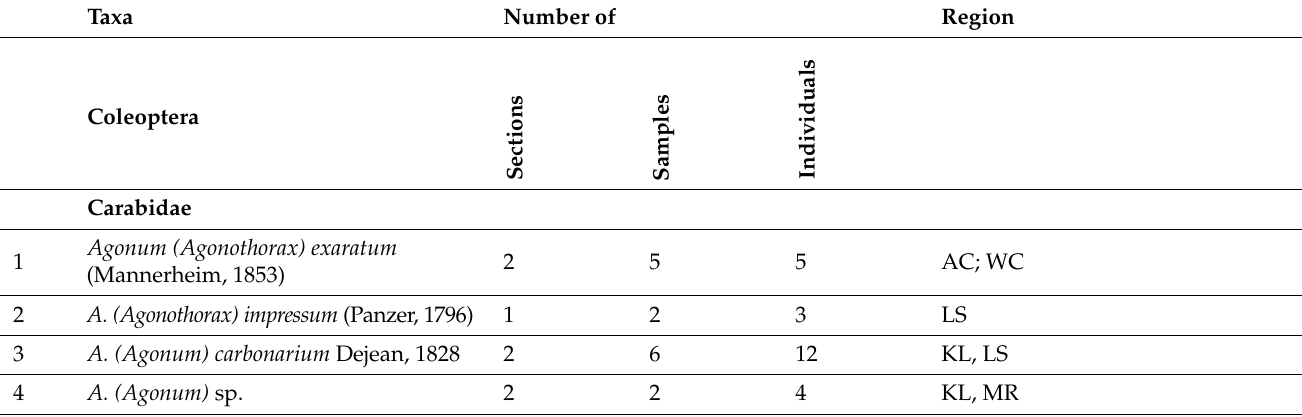
Figure 11. Remains of true aquatic insects: ( a )—Odonata larvae wing pad., ( b – d )—plant-silt cases of Trichoptera, Brachycentridae: ( b )— Brachycentrus subnubilus , ( c )— Micrasema sp., ( d )— Micrasema gelidum , ( e ) sand case of Apataniidae, ( f ) sand case of Molanna sp., ( g , h )— Limnephilus spp.: ( g ) plant case, ( h ) sand case, ( i ) shell case, ( j ) case from shells, seeds and a beetle elytron; ( a , b , h )—Kharyyalakh, Holocene, ( c ) Old Crow, late Pleistocene (MIS5), ( d , e , f ) Ulakhan-Sullar, middle Pleistocene, ( g ) Kyzyl-Syr, late Pleistocene (MIS3) peat, ( i , j ) Peschanay Gora, late Pleistocene (MIS2). Table 1. List of aquatic beetles from Quaternary deposit of Beringia. The group “ri” (Table 2) includes beetles of families Carabidae, Hydrophilidae, Staphylin- idae, Scarabaeidae, Scirtidae, Heteroceridae, Elateridae, Coccinellidae, Chrysomelidae, Curculionidae, and bugs Saldidae. These insects live on wet ground, in plant litter near water bodies (Figure 12), or on riparian and wetland vegetation (Figure 13). Many riparian species can migrate to dry soils for wintering. In the cold climate, some riparian species occasionally visit dry and sunny spots to get some heat necessary for their development. Anyway, the find of “ri” group suggests that a water body existed not far from the place of burial of the insect remains. Table 2. List of riparian and wetland insects from Quaternary deposit of